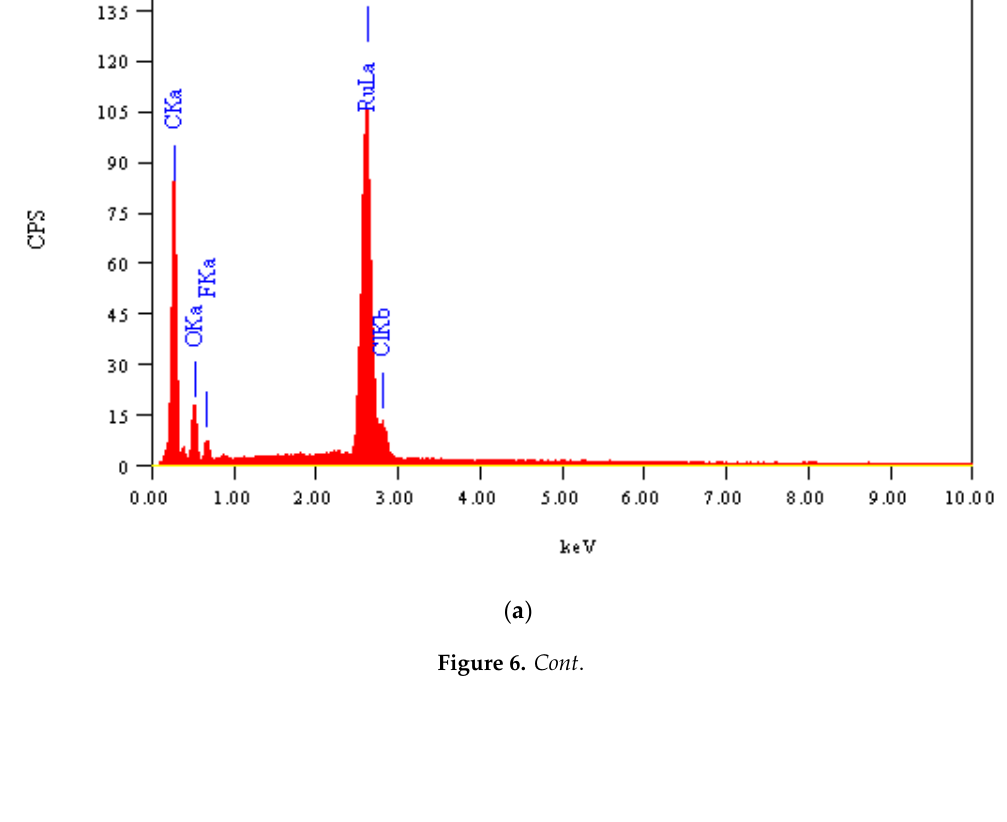
Figure 5. ( a ) SEM micrograph of Complex 1; ( b ) SEM micrograph of Complex 2 ; ( c ) SEM micrograph of Complex 3 .